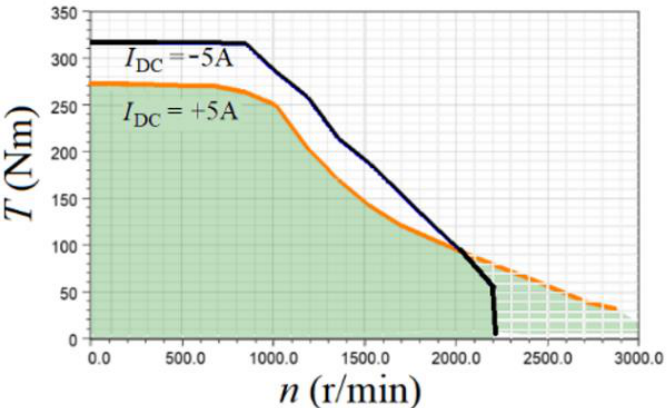
Figure 11. Torque – speed envelopes compared under different DC coil currents, at DC coil current Figure 11. Torque–speed envelopes compared under different DC coil currents, at DC coil current I DC = − 5 A (black line — field-strengthening operation region) and I DC = +5 A (orange line — field-weak- I DC = − 5 A (black line—field-strengthening operation region) and I DC = +5 A (orange line—field- ening operation region). weakening operation